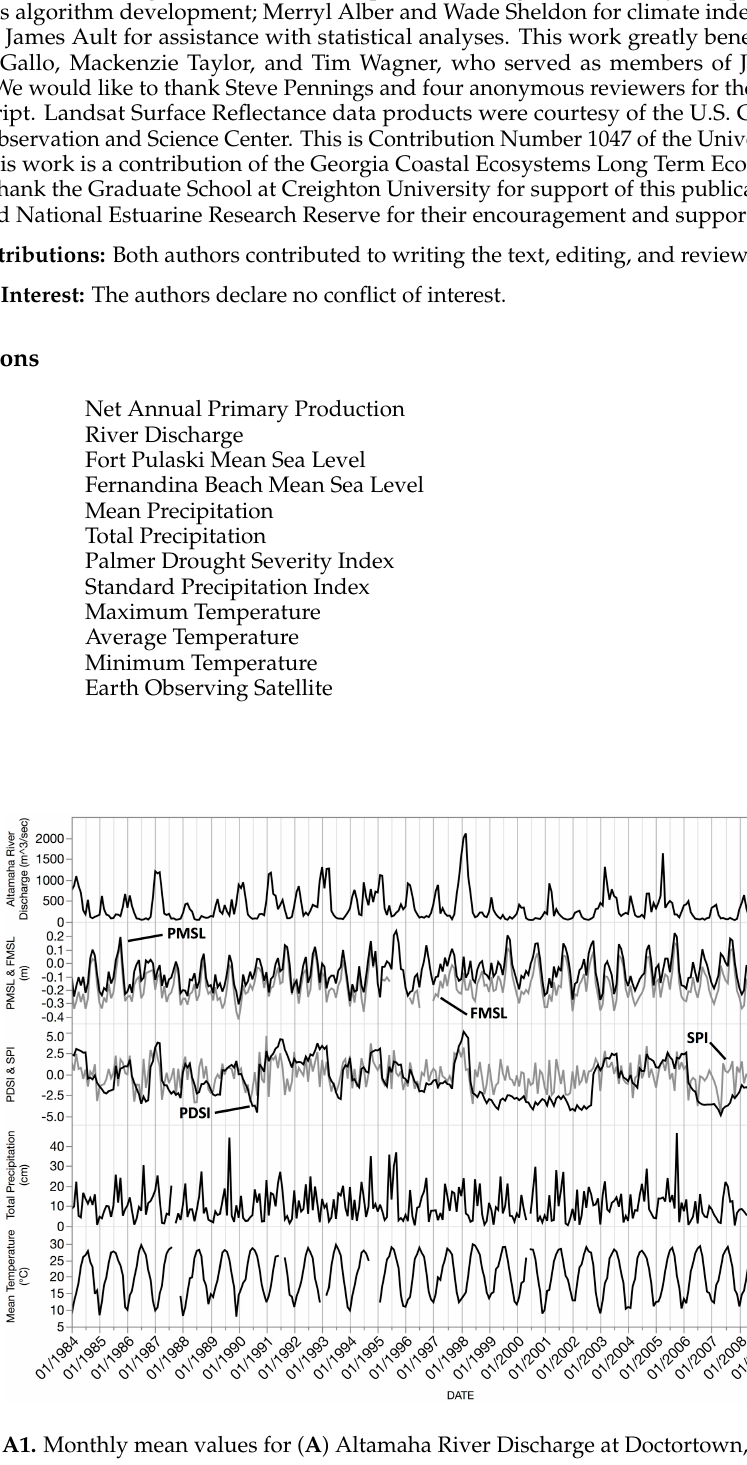
Figure A1. Monthly mean values for ( A ) Altamaha River Discharge at Doctortown, GA; ( B ) Mean Sea Level relative to NAVD88 for Fort Pulaski, GA and Fernandina Beach, FL; ( C ) Palmer Drought Severity Index (PDSI) and Standard Precipitation Index (SPI) for Georgia, region nine; ( D ) Total Precipitation and ( E ) Mean Temperature at Brunswick, GA over a 28-year period. Note that SPI was multiplied by 1.5 in order to amplify the signal to better identify trends when plotted. Gaps in data represent periods of missing observations. Table A1. Pearson’s correlation coefficients (lower matrix) and probability values (upper matrix) for external drivers and biomass of three S. alterniflora height classes across all dates ( n = 294) from 1984 to 2011. The correlations are estimated by the Pairwise method.